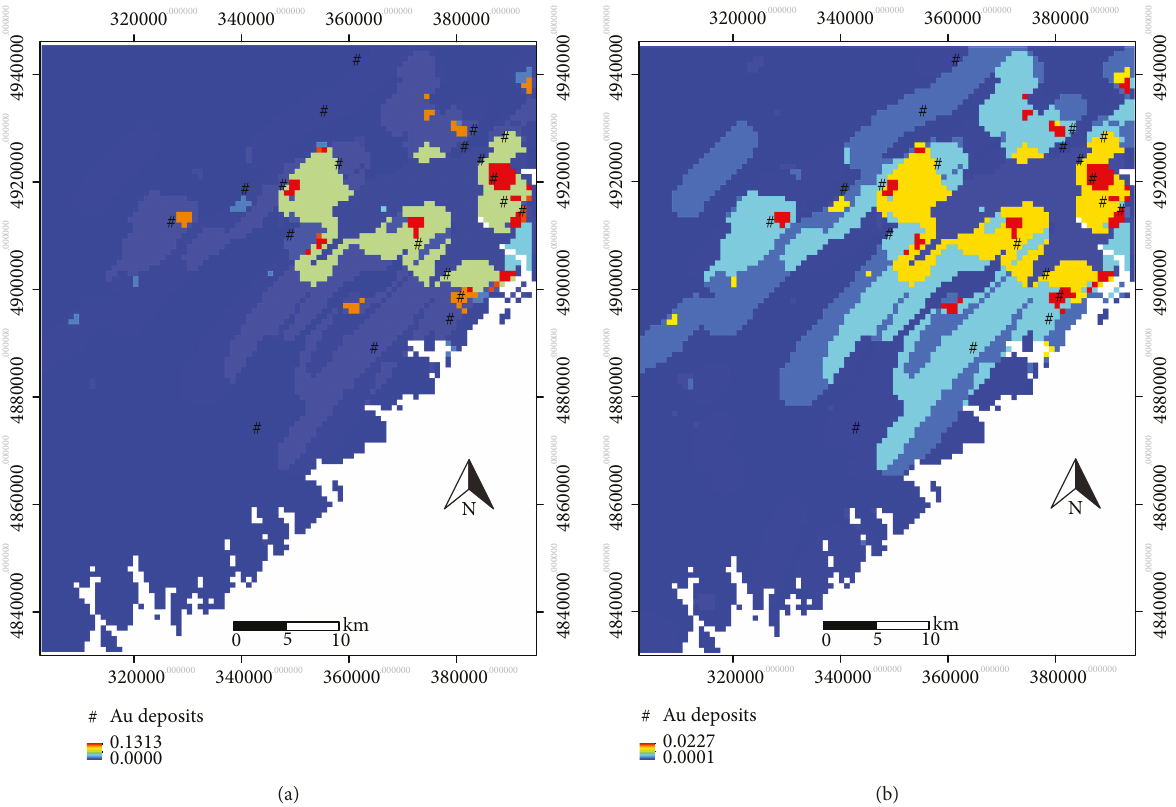
Figure 6: Posterior probability maps obtained by (a) weights of evidence and (b) logistic regression in experiment